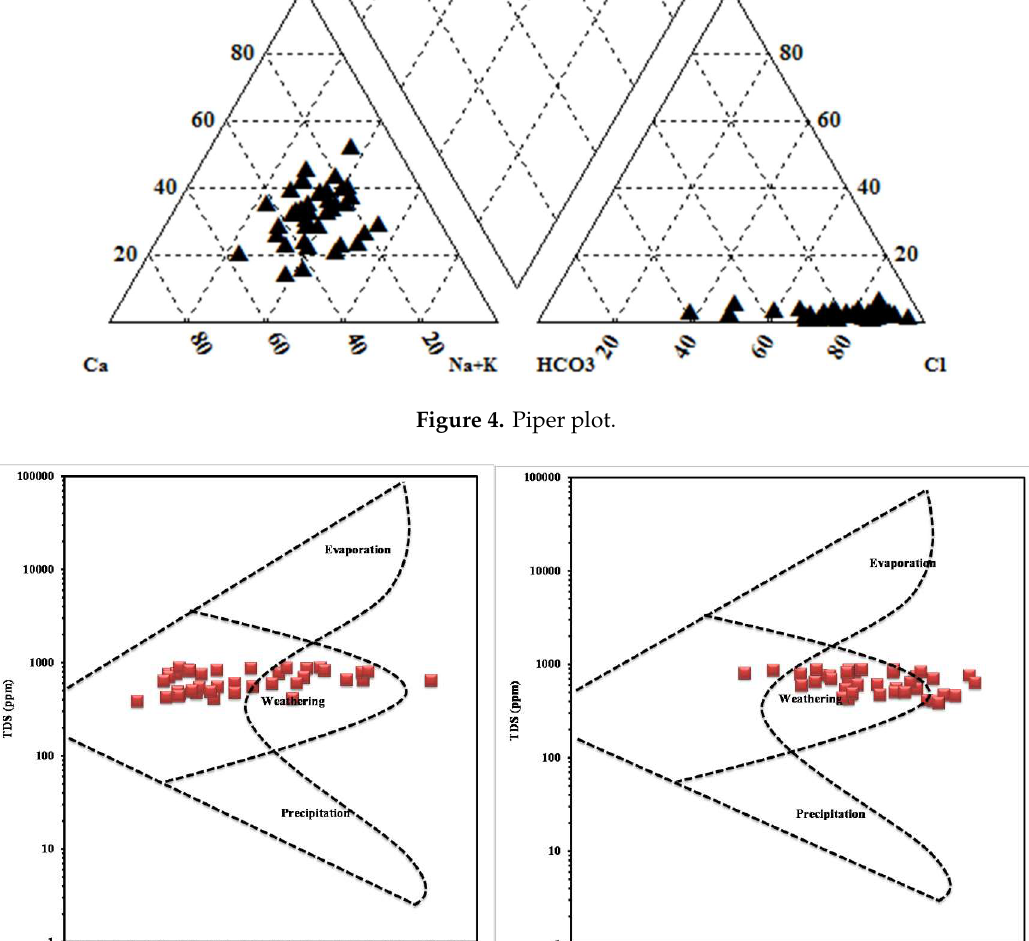
Figure 5. Gibbs plot